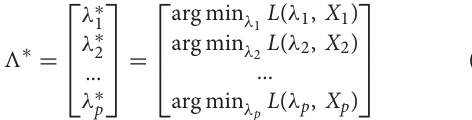
Figure 1D . The corresponding pseudo-code is given in Algorithm 1 . Before applying the Box-Cox